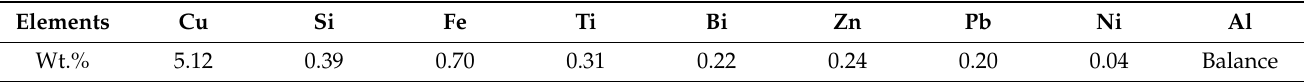
Table 1. Chemical composition of the initial AA2011